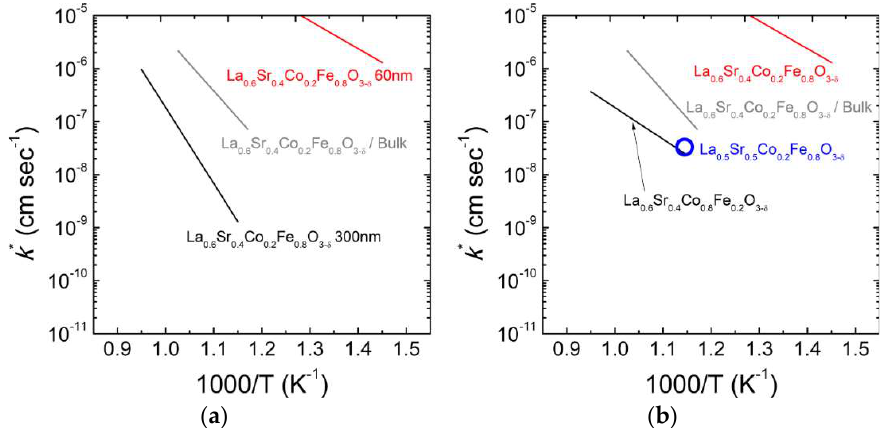
Figure 5. Arrhenius plots of surface exchange coefficients ( k * ) for La 1-x Sr x Co 1-y Fe y O 3-δ thin films. ( a ) Effect of strain on k * for La 0.6 Sr 0.4 Co 0.2 Fe 0.8 O 3-δ [117] and La 0.6 Sr 0.4 Co 0.2 Fe 0.8 O 3-δ [118] films and La 0.6 Sr 0.4 Co 0.2 Fe 0.8 O 3-δ (Ref. [119]) polycrystalline samples. ( b ) Effect of Sr substitution on k * for La 1-x Sr x Co 1-y Fe y O 3-δ (red [117], black [47] and blue [114]) films and La 0.6 Sr 0.4 Co 0.2 Fe 0.8 O 3-δ [119] polycrystalline oxides.